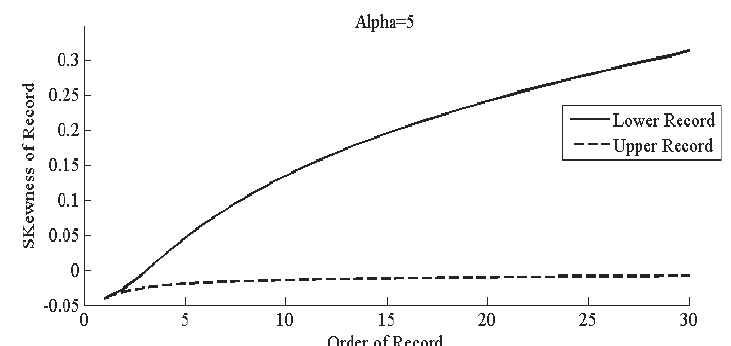
Figure 13 – Skewness coefficient of records.